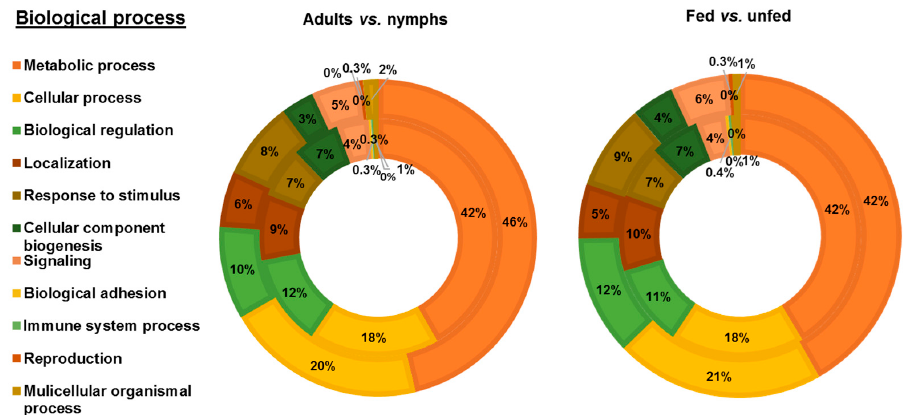
Figure 3. Biological process categorization of PRM proteins identified after proteomics analysis. Proteins were functionally annotated and grouped according to biological process using Blast2GO software and manual search. The same protein could have several GO annotations, a fact that was included in the results shown in the graphs. Left picture: Distribution of proteins identified in female adult PRM (inner circle) and nymph PRM (outer circle). Right picture: Distribution of proteins identified in fed PRM (inner circle) and unfed PRM (outer circle).